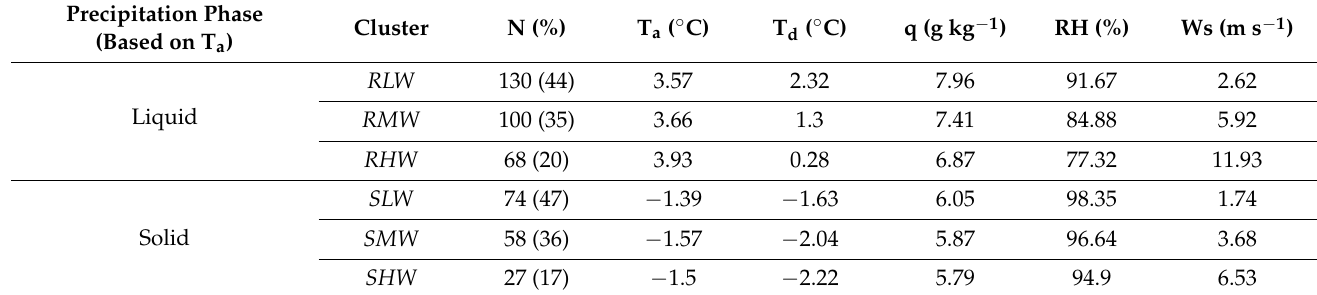
Table 6. Cluster means of solid and liquid precipitation records estimated at 15 min time scale by using K-means. N represents the number of records per group, parentheses are show the contribution for each phase respectively. Precipitation Phase (Based on T a